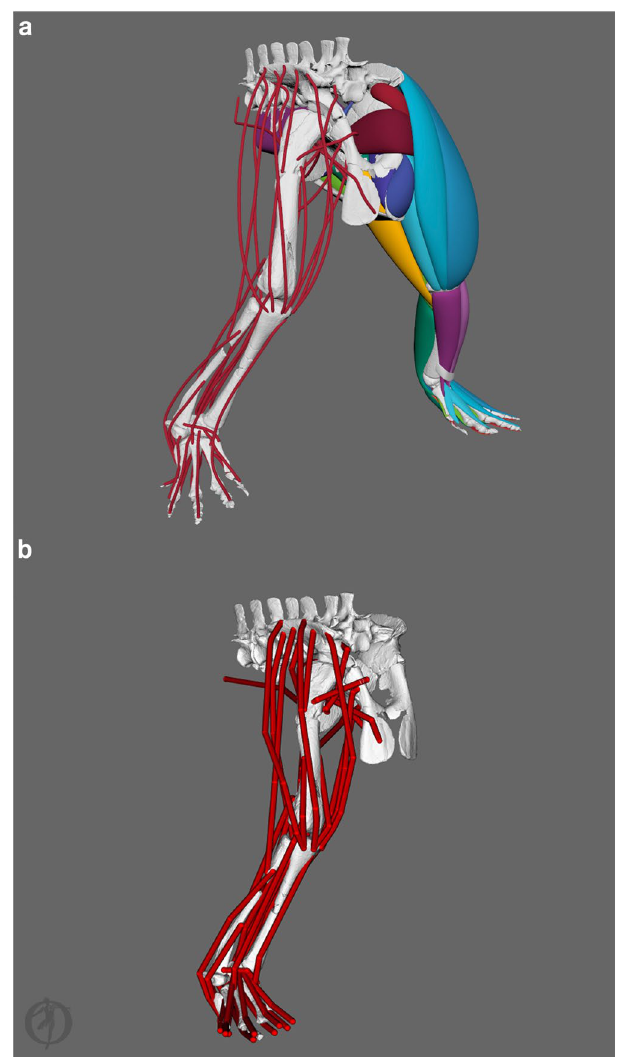
Figure 4. Muscle modelling and LoA estimation of Euparkeria capensis . ( a ) 3D volumetric muscle models and estimated LoAs. ( b ) OpenSim model with muscle paths adjusted to match the LoA based on the volumetric muscle